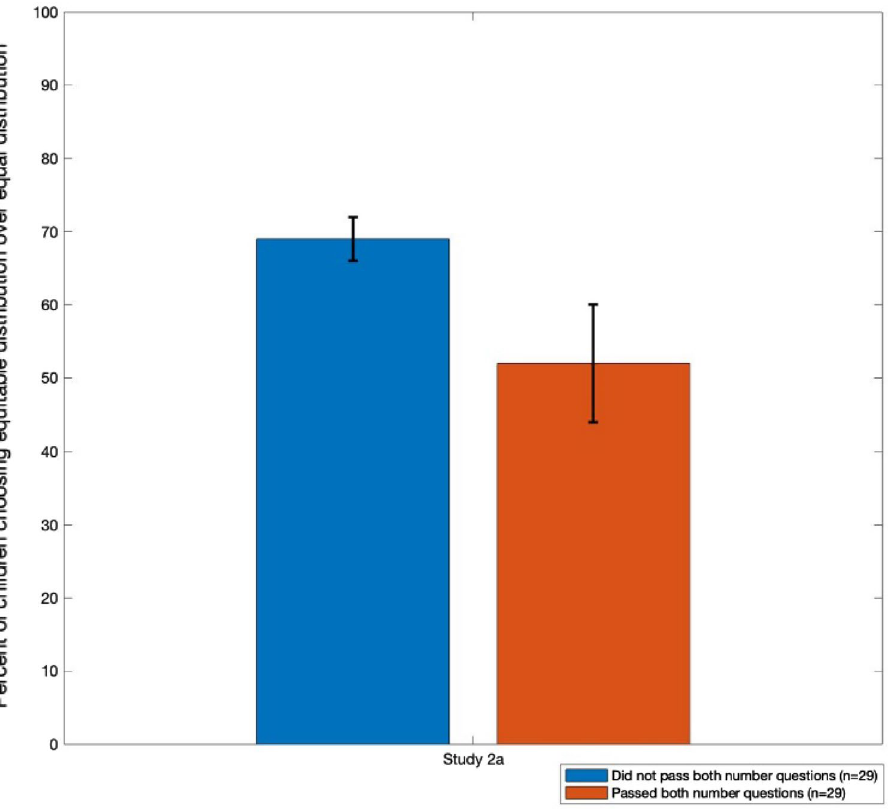
Figure 3. Percentage of children who chose the equitable distribution in Study 2b depending on whether they respond correctly to the two number questions (second